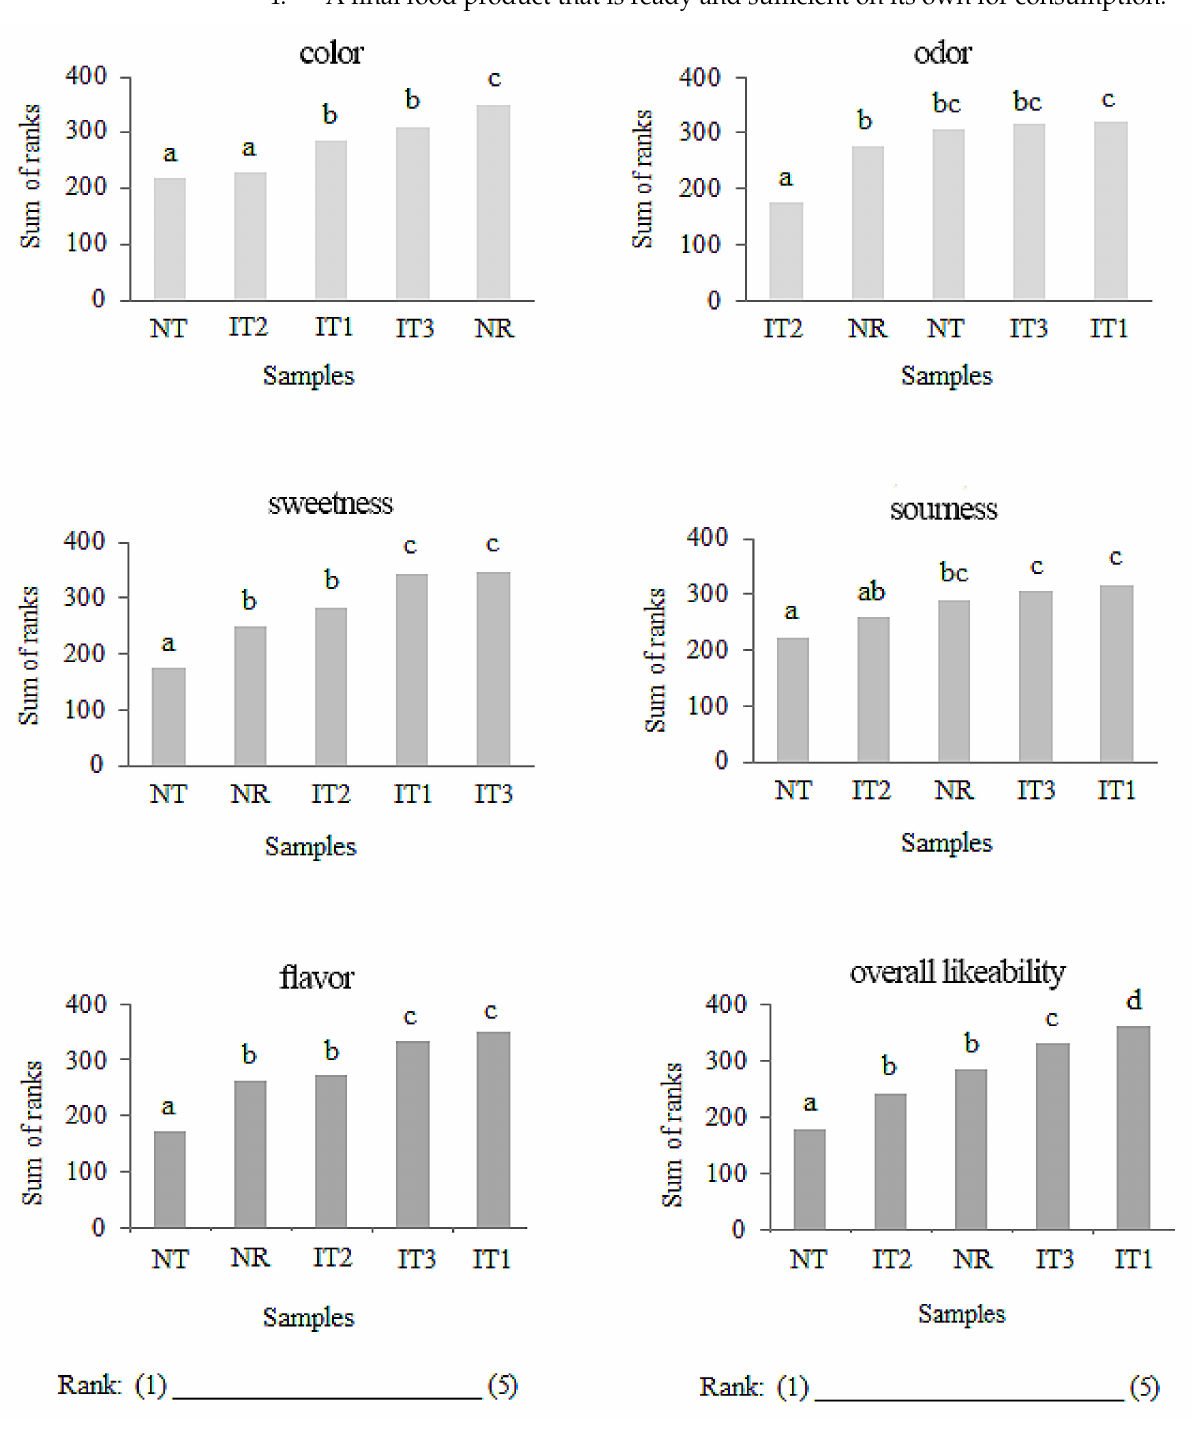
Figure 4. Results of preference ranking test of beverage samples. IT1, peach-flavored iced tea; IT2, black elder-flavored iced tea; IT3, forest fruit-flavored iced tea; NT, NADES thyme extract-based soft drink; NR, NADES raspberry seeds extract-based soft drink. Values marked with the same letter are not statistically different ( p <